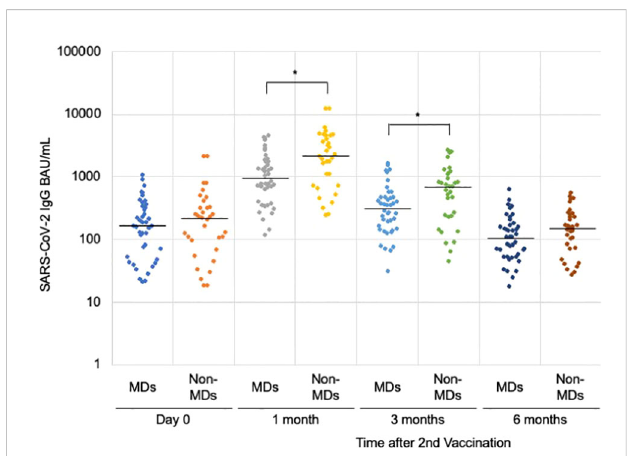
FIGURE 2 Anti-SARS-CoV-2 IgG antibody levels after the second vaccination. Comparing the muscular disorders (MDs) group (n = 42) with the non- MDs group (n = 33), a signi fi cant difference was observed at 1 and 3 months after the second vaccination with the BNT162b2 mRNA vaccine. The solid lines represent the median titers of each group. * indicates p -value less than 0.01.